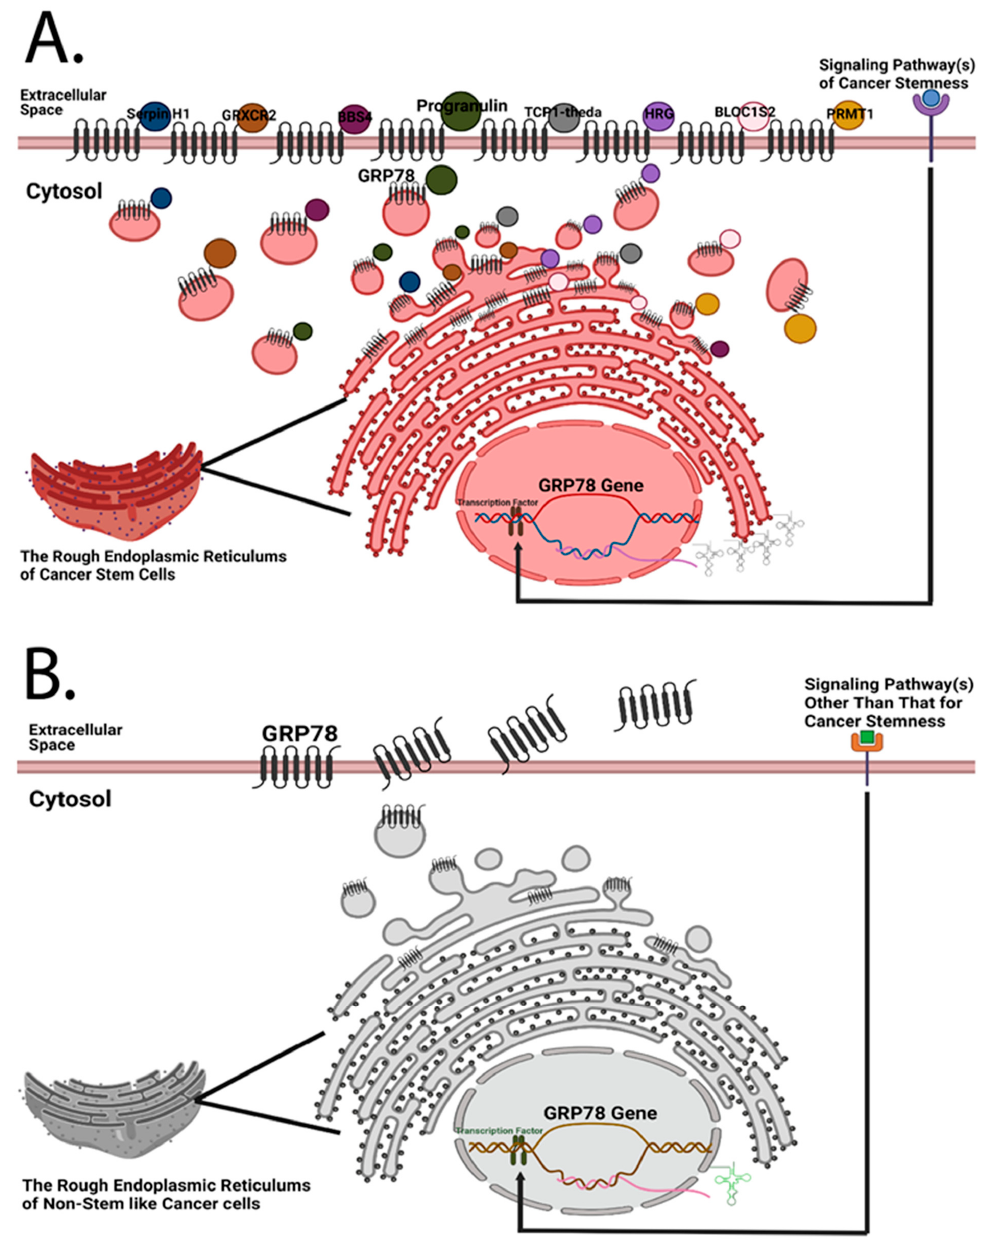
Figure 2. Both cancer stem cells and non-stem-like cancer cells are hypothesized to express cell surface GRP78, but the amounts of cell surface GRP78 and its interactome of these two types of cells are different. ( A ) Previously, Chen et al. designed a quantitative mass spectrometry platform to detect the interactome of cell surface GRP78 in head and neck cancer cells [7]. Given that GRP78 silencing has a regulatory influence on stemness-related markers [7], it is logical to hypothesize that cancer stem cells possess a more diverse GRP78 interactome than non-stem-like cancer cells; and that cancer cells expressing a higher amount of cell surface GRP78 may possess the highest hierarchical rank of cancer stemness. ( B ) Due to the higher proliferation rate of cancer cells, an increase in plasma membrane synthesis in the endoplasmic reticulum is required, resulting in the translocation of resident chaperone GRP78 to the cell surface. Under this circumstance, non-stem-like cancer cells may express a certain amount of cell surface GRP78 even if there are no plasma membrane-bound proteins that need to be chaperoned to the subcellular compartment of the plasma membrane. GRP78 is likely secreted